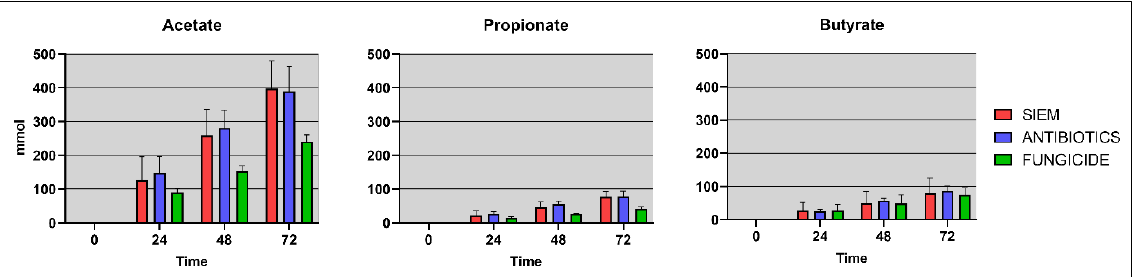
Figure 8. Cumulative SCFA levels (mmol/L) for the different treatment groups.